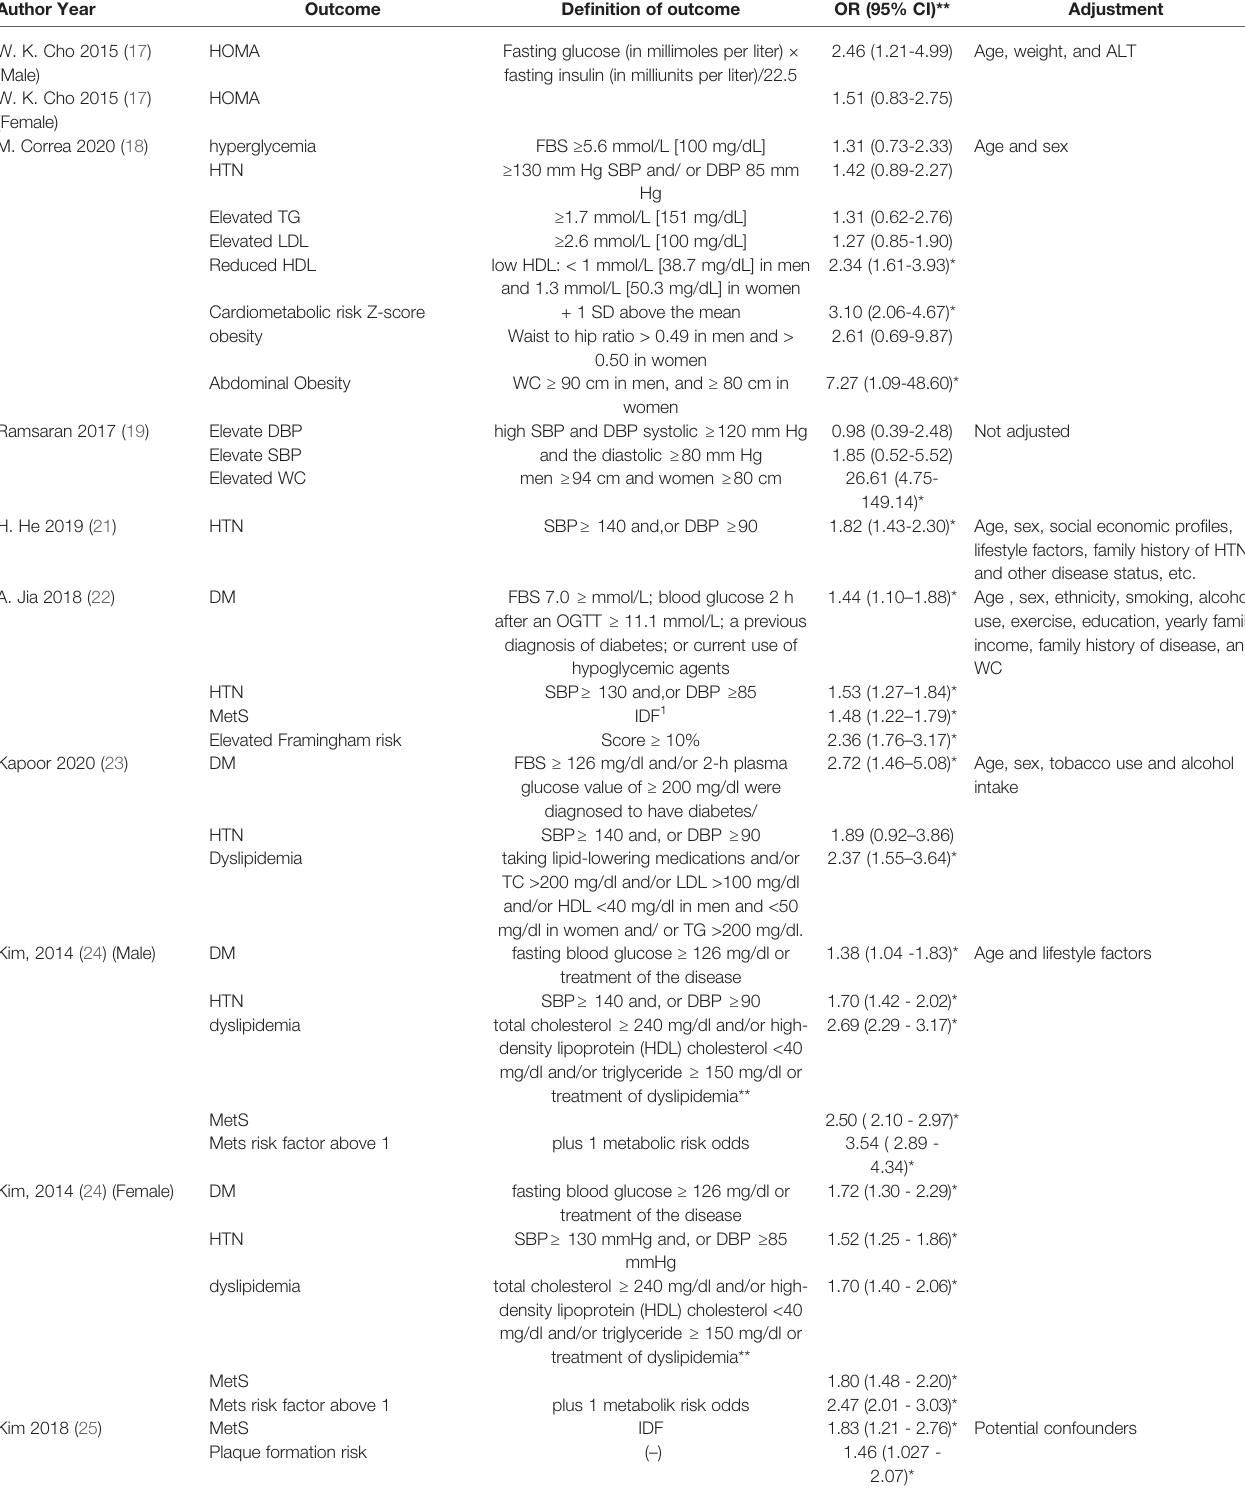
TABLE 3 | Association of NWO with CMRFs in included